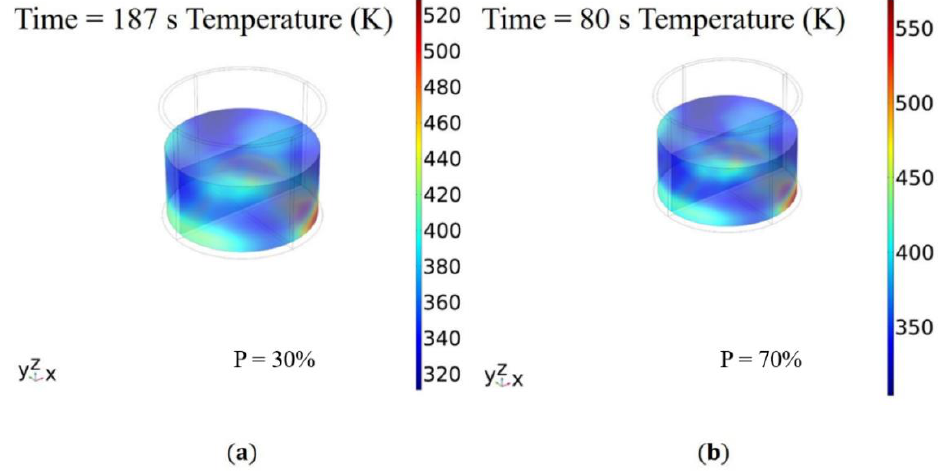
Figure 4. Comparison of the calculated and measured results for heating 100 cm 3 of water to 100 ◦ C at 30% ( a ) and 70% ( b ) power